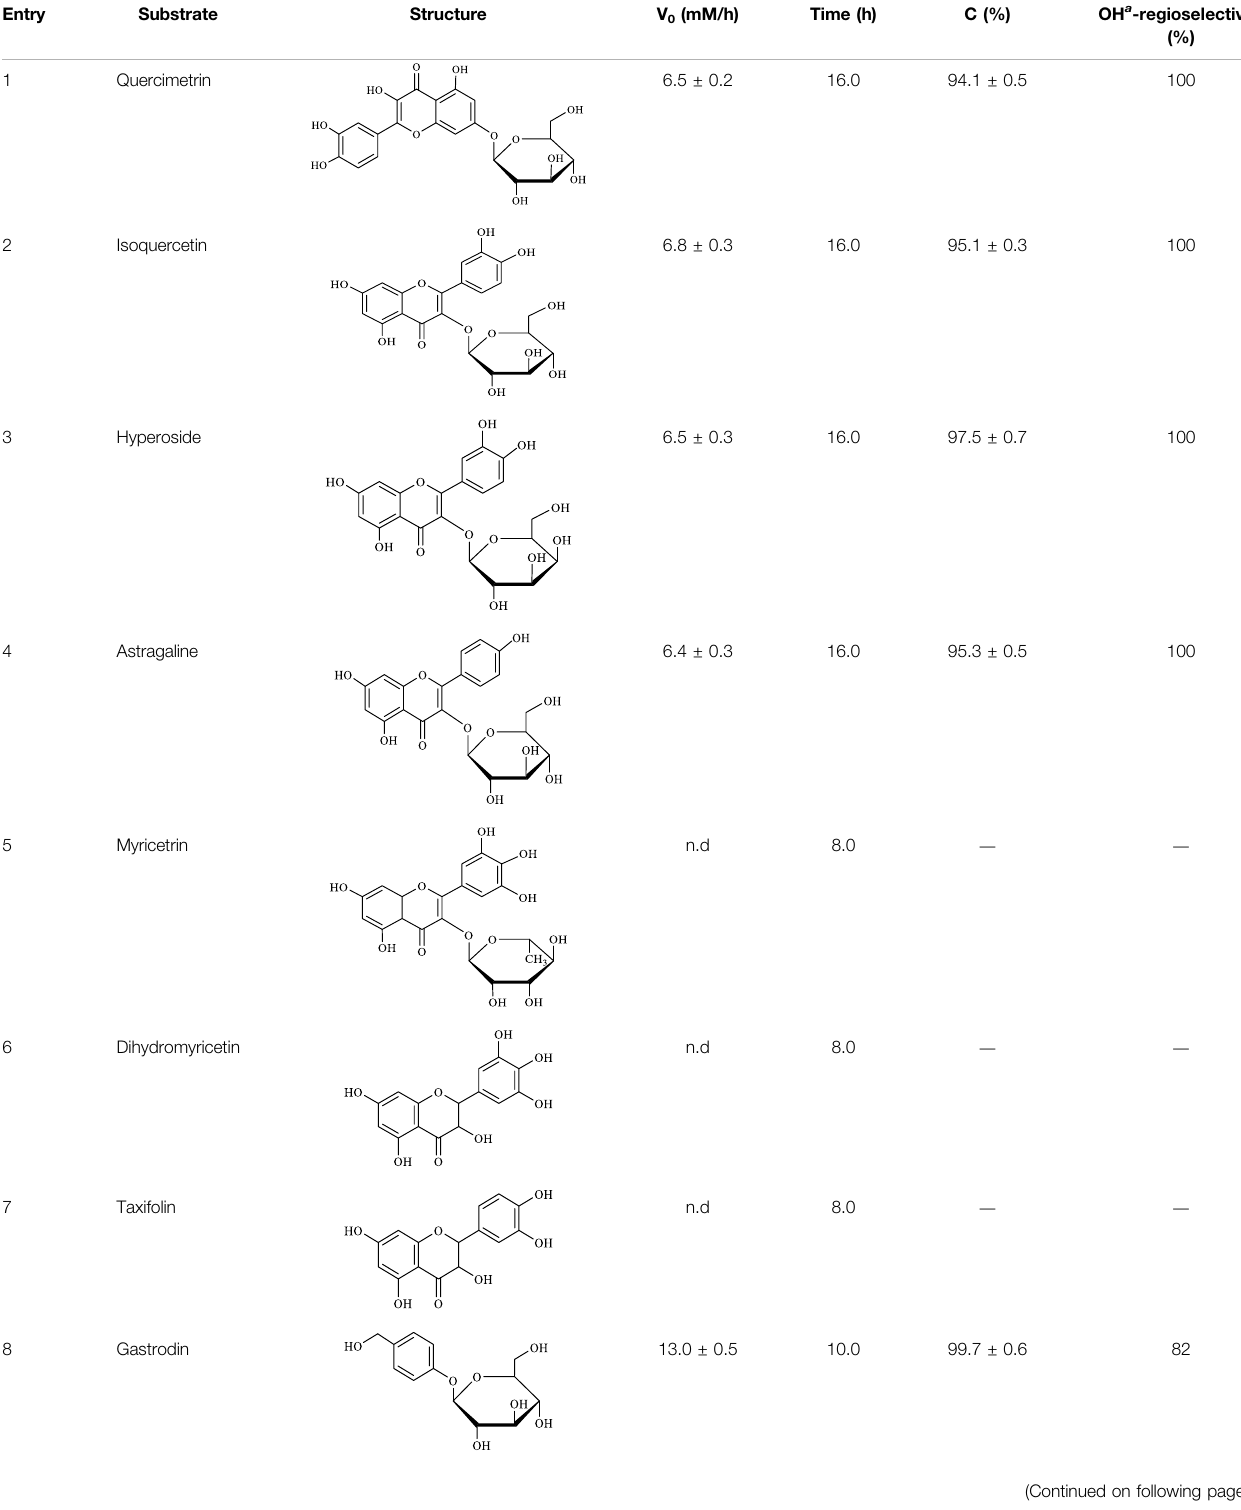
TABLE 4 | Effect of chemical construction of substrate on the acylation catalyzed by Fe 3 O 4